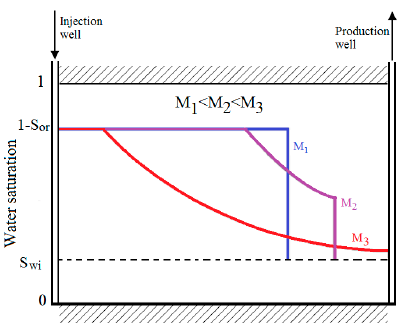
Figure 1. Water saturation profile of different mobility ratio ( M ).